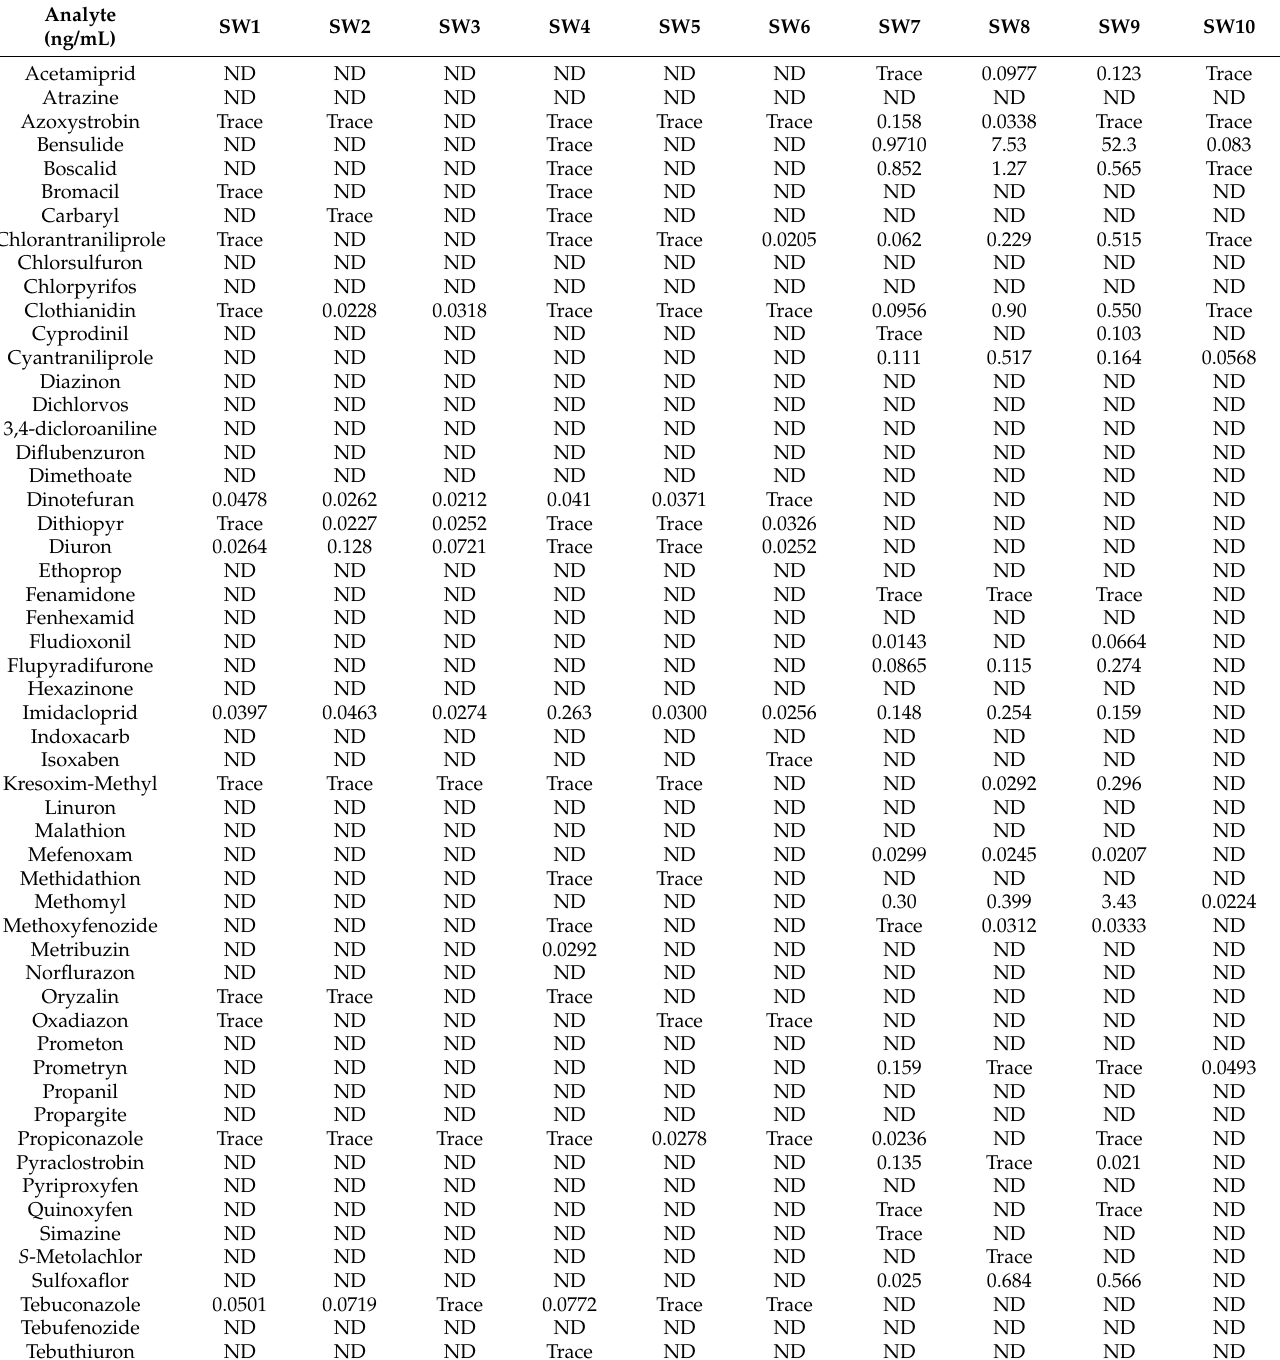
2 spiked labeled standards and showed different levels of pesticide residue. Labeled standard recoveries were between 72.6% and 105.2%, with a relative standard deviation between 7% and 13%. As shown in Table 2, this rapid and simple method investigated the presence of bensulide, chlorantraniliprole, chlothianidin, cyantraniliprole, dinotefuran, diuron, imidacloprid, methomyl, thiamethoxam, fipronil, fipronil sulfone, and desufinyl fipronil in more than one-third of samples. This extraction approach was successfully applied for the routine analysis of all aquaculture waters with various levels of particulates. Table 2. 10 surface water samples were measured for all pesticides with this optimized SPE method. Analyte